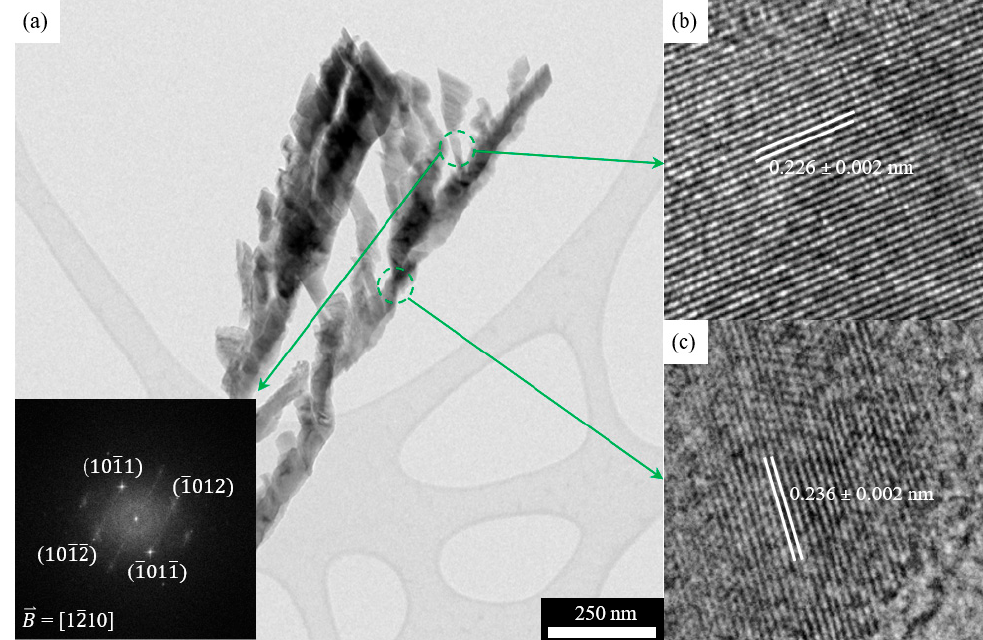
Figure 5. ( a ) HRTEM image of a Ti nanorod having branches with the inset showing selected area diffraction (SAED) pattern of the circled spot, ( b ) lattice spacing of the circled spot of the branch. ( c ) Lattice spacing of the circled spot of the nanorod.